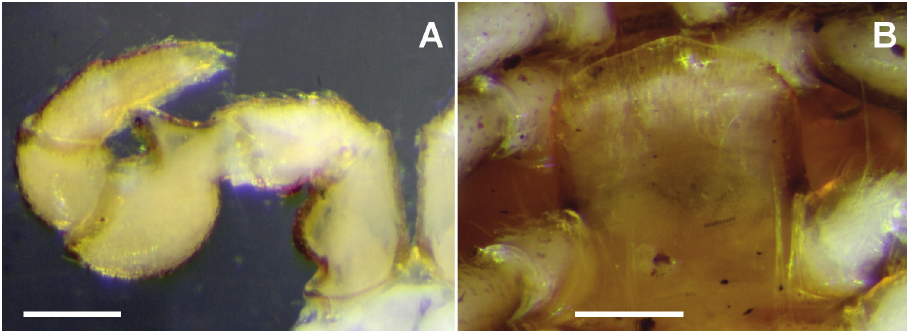
Figure 2. Taxidiotisoma portabile sp. n., male ex NMV K-12071. A Leg 1 B Sternal lamella on ring 5, posterior view. Scale bars: 0.2 mm.